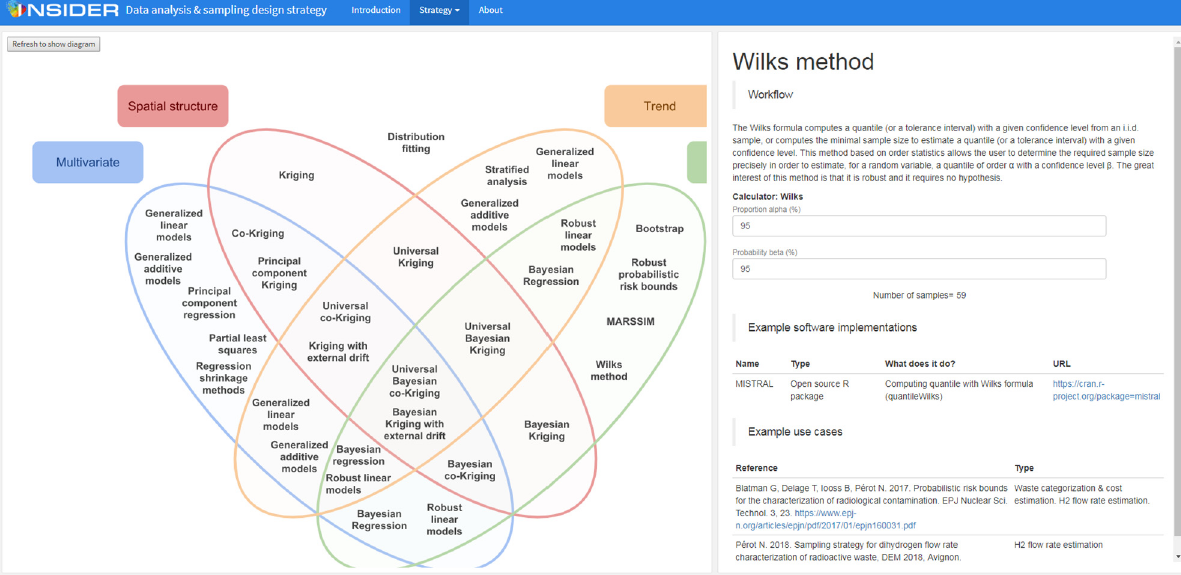
Fig. 8. Example of a detailed page for data analysis (Wilks method), with the overview of methods in the Venn